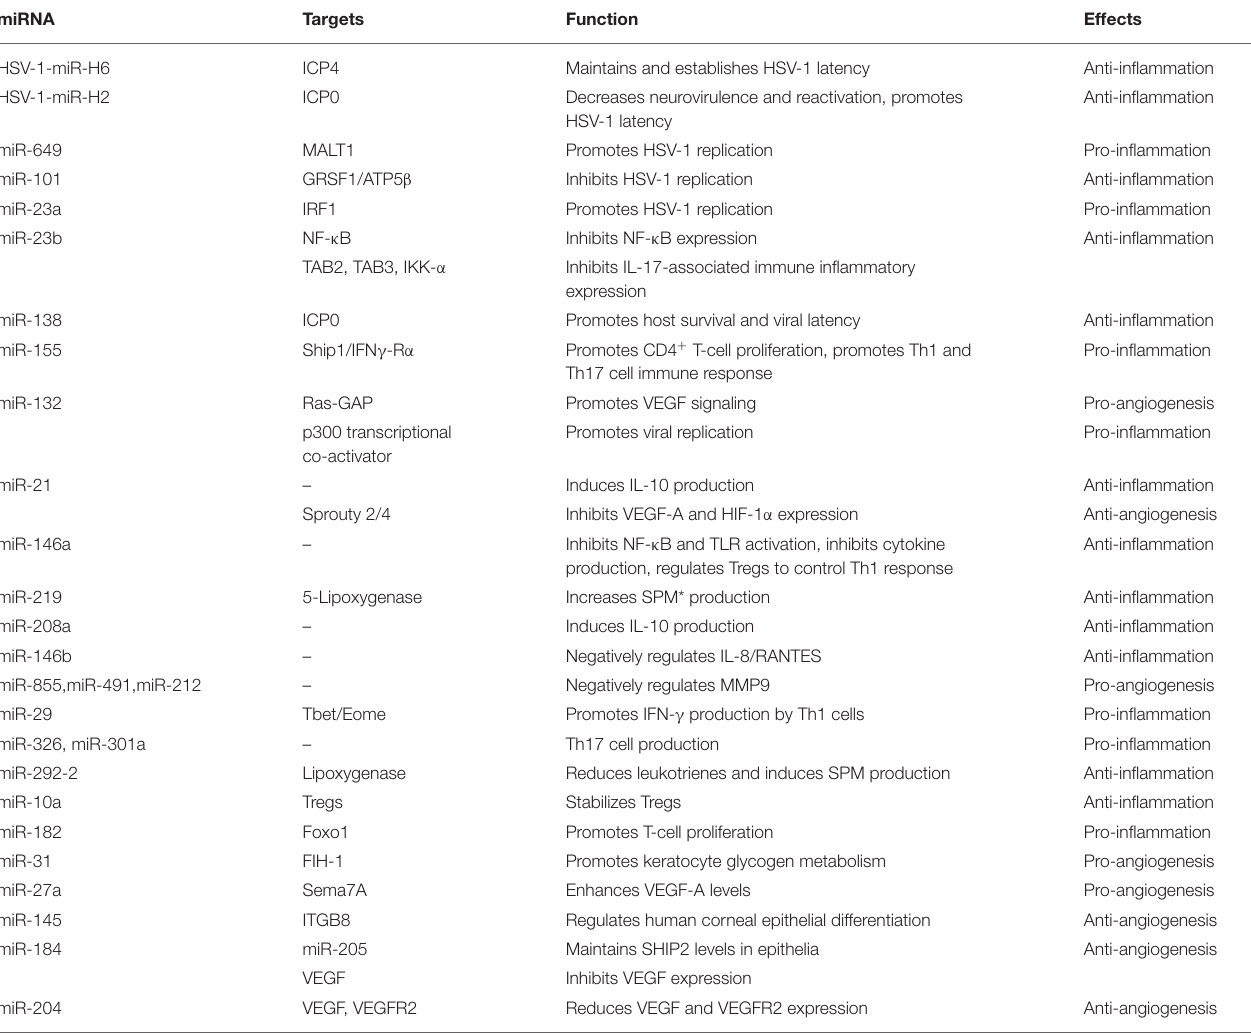
TABLE 1 | Role of microRNAs in herpes stromal keratitis (HSK) (108, 109, 114,